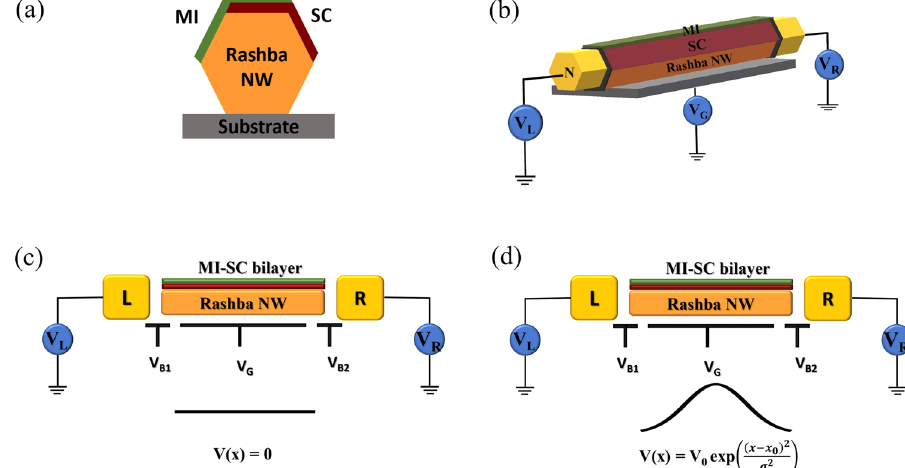
Fig. 1 Device schematics. a Cross section of Rashba nanowire epitaxially epitaxially coated with a superconductor (SC) and a magnetic-insulator (MI), showing overlapping SC and MI layers. b A 3-D schematic of the device setup with the nanowire connected to two normal contacts via tunnel barriers, and a gate to control chemical potential, μ . c , d Effective 1D models used for computation, treating MI-SC as a stacked bilayer, with the homogeneous and inhomogeneous chemical potential pro fi les shown